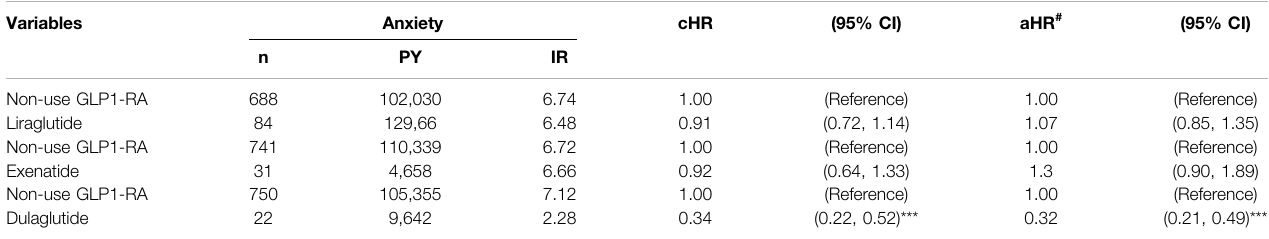
TABLE 6 | Cox proportional hazard model estimated GLP1-RA hazard ratio of anxiety among different GLP1-RA types.